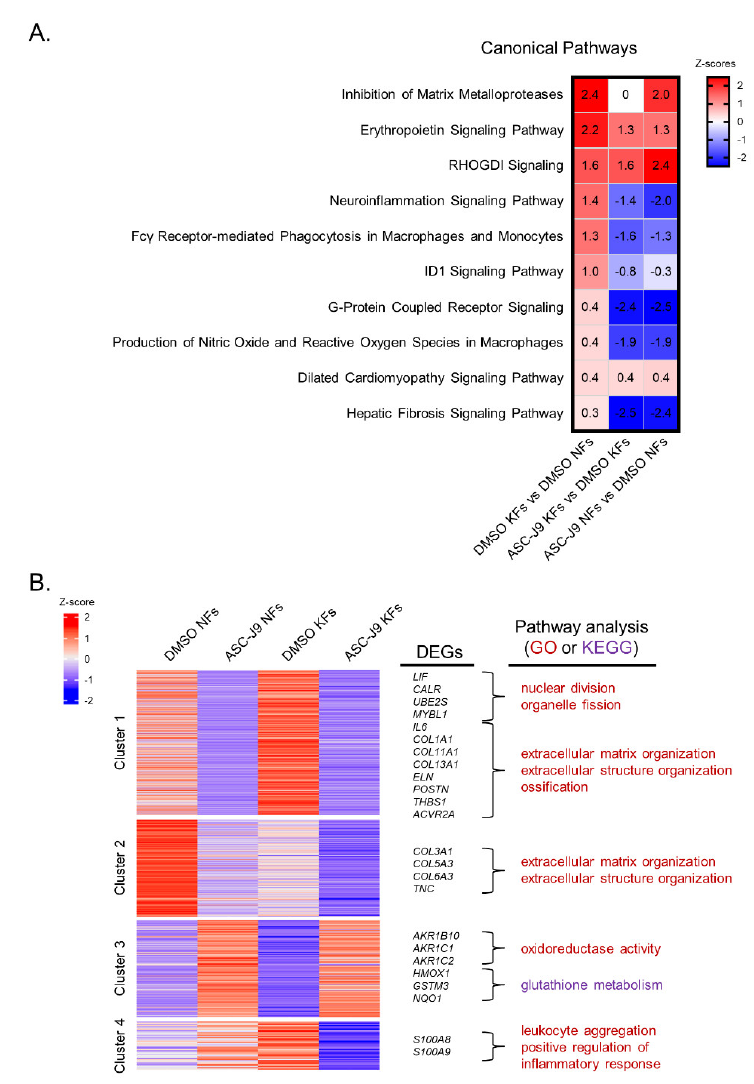
Figure 3. The transcriptomic profiling of normal and keloid fibroblasts, showing the inhibitory